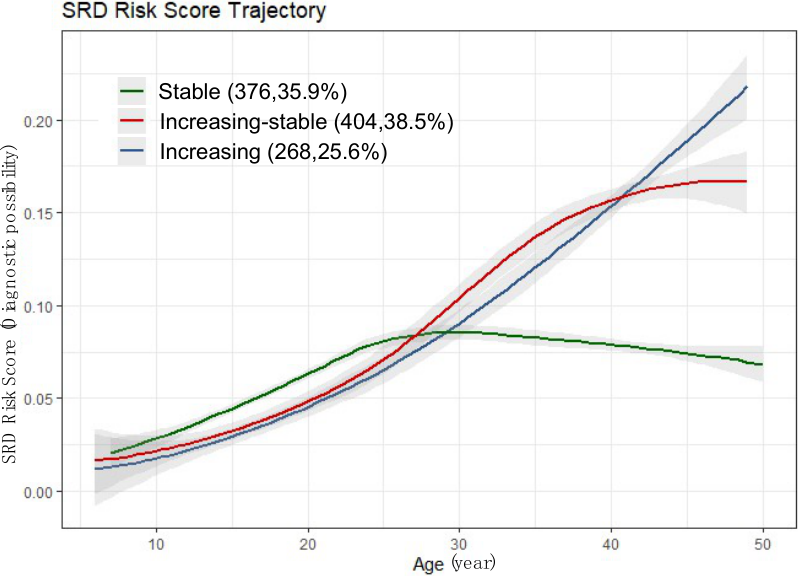
Figure 4. Three SRD risk score trajectory groups identified in this study using group-based trajectory modeling analysis: stable group, increasing-stable group and increasing group. SRD, subclinical renal damage.